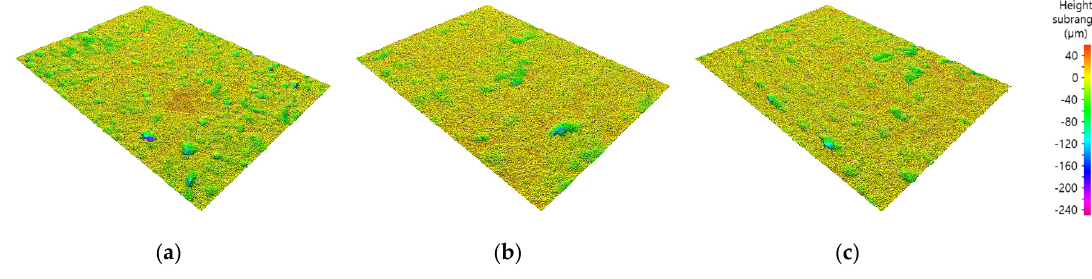
Figure 9. Surface texture of ( a ) HfC, ( b ) TiC, and ( c ) HfC/TiC coatings.